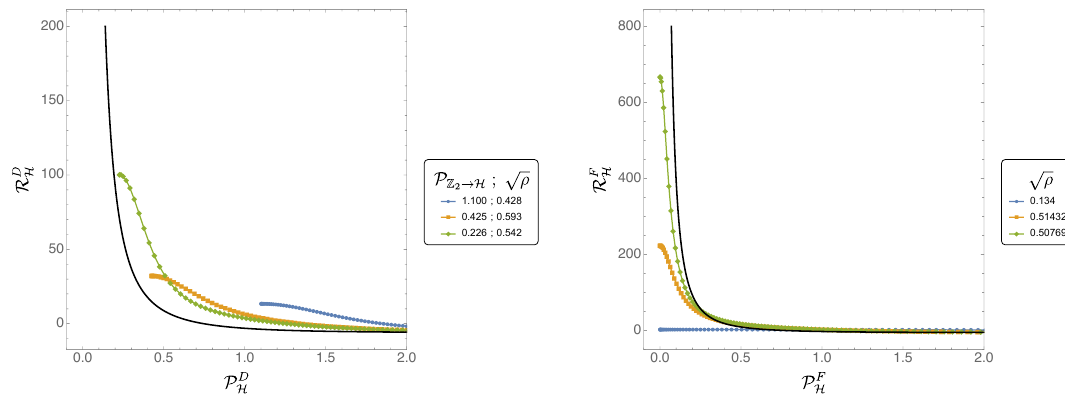
Figure 13 . Comparisons of the horizon geometries in our numerical solutions with that of (6.2). The quantity P F refers to proper distance along the funnel horizon measured from the plane of Z 2 H symmetry, while P D measures proper distance along a curve that (cid:12)rst runs from the plane of Z 2 H symmetry to the droplet and then along the droplet horizon. The quantities R F scalars at corresponding horizon points. We compare P F quantities (solid lines) computing on the horizon of (6.2). The annotations show the relevant values p of (cid:26) and, for the droplets, the proper distance along the rotation axis from the symmetry plane and the droplet tip (which is a natural measure of the distance of any given solution from the transition).